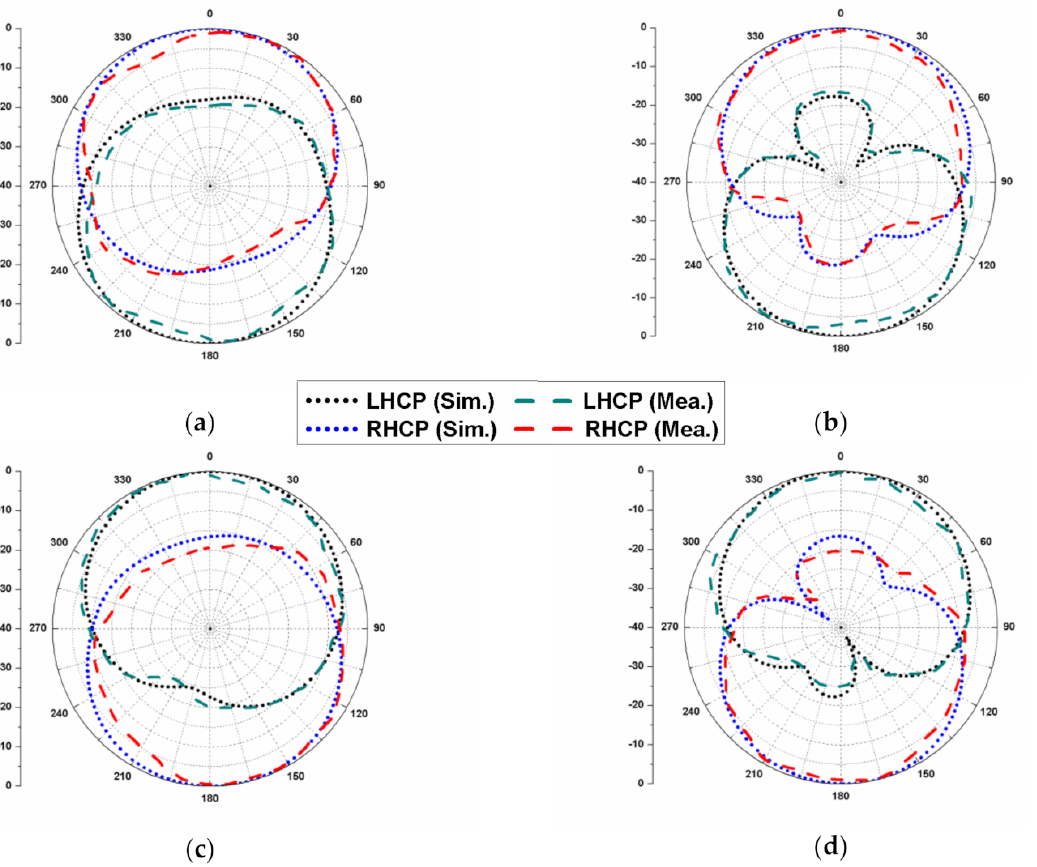
Figure 12. Radiation patterns of the dual CP MIMO antenna at 3.6 GHz: ( a ) port 1, ϕ = 0 ◦ ; ( b ) port 1, ϕ = 90 ◦ ; ( c ) port 2, ϕ = 0 ◦ ; and ( d ) port 2, ϕ = 90 ◦